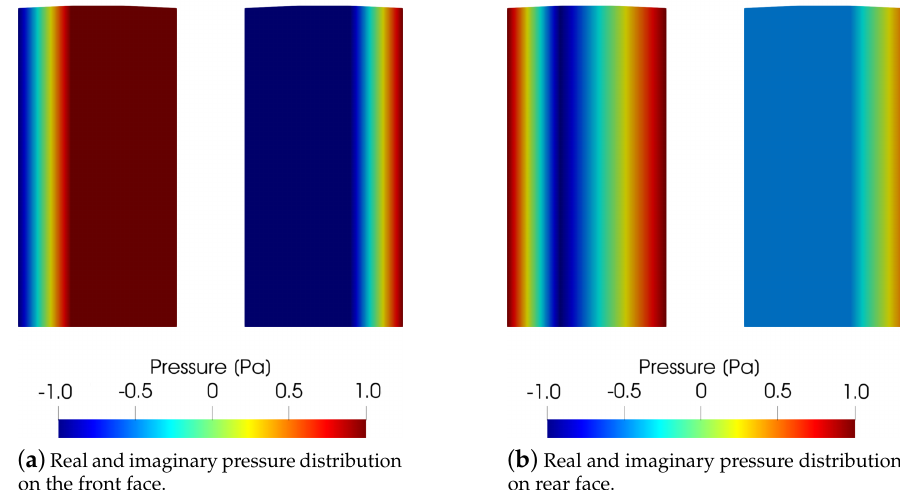
( a ) Real and imaginary pressure distribution on the front face. Figure 4. Selected forcing function distribution (case